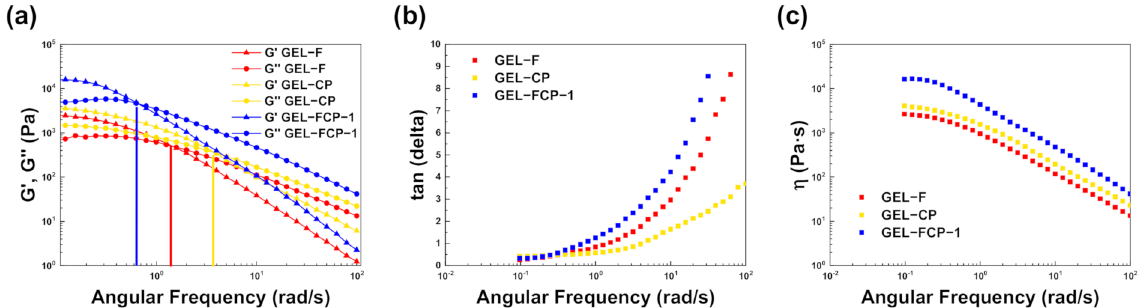
Figure 4. ( a ) G (cid:48) and G (cid:48)(cid:48) determined by oscillatory stress sweep measurements of each samples at the shear stress of 1.0 Pa. 200 s; ( b ) loss factor tan δ as a function of angular frequency; ( c ) shear viscosity of resultant each